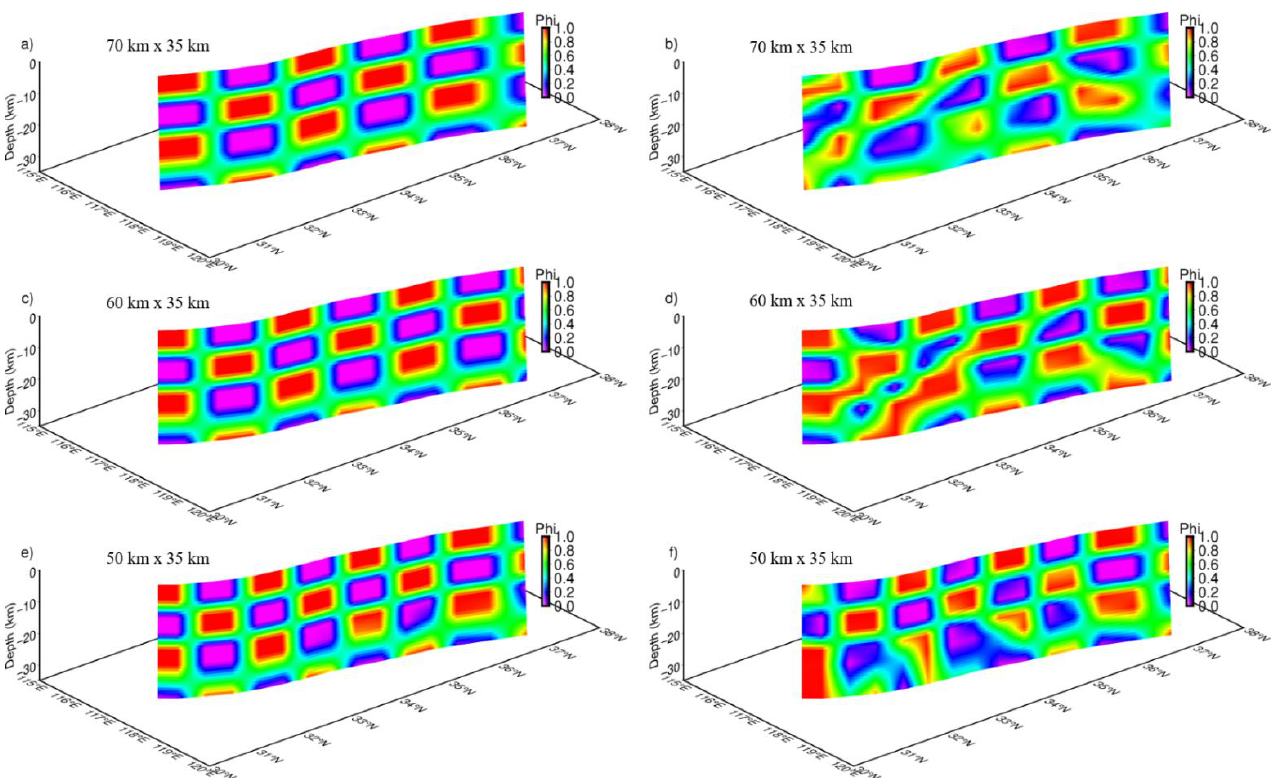
Figure 7. Resolution tests for coupling ratios inverted by different distances between adjacent fault nodes. Figures on the left ( a , c , e ) are 3D distribution of coupling ratios for forward modeling, and on the right ( b , d , f ) are recovered 3D distribution of coupling ratios using the same inversion strategy.